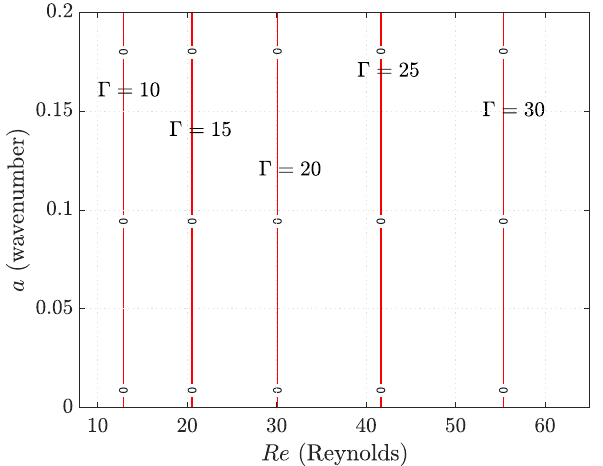
Figure 13. First-order approximation of the neutral stability curves, downhill flow. Γ = 10,15,20,25,30, θ = π /4, λ = 1.